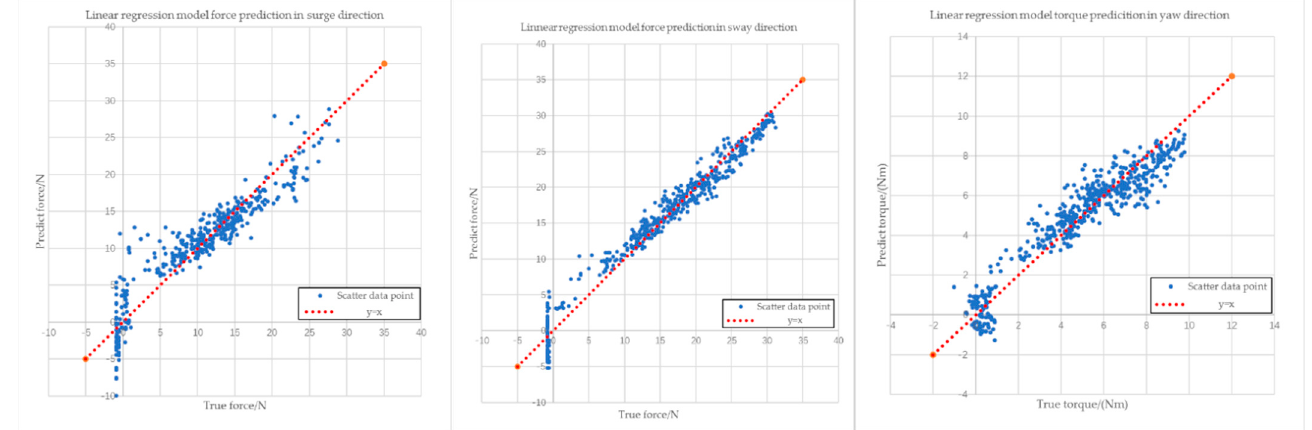
Figure 9. Regression models predicting scatter images in surge, sway and yaw directions. The horizontal axis represents the real disturbance value of the robot measured by the force/torque sensor; the vertical axis represents the disturbance value predicted by the model; the red line is the y = x line; each blue point represents a set of artificial lateral-line data; its abscissa is the corresponding real value of the disturbance; and the ordinate is the predicted value of the disturbance output by the model. Theoretically, the closer the blue point is to the y = x line, the closer the disturbance value predicted by the model is to the real disturbance value, and the better the prediction effect of the model is. On the contrary, the farther the blue point is from the y = x line, the more the disturbance value predicted by the model deviates from the real disturbance value, and the worse the prediction effect of the model is. The distance from the blue point to the red line in the Y -axis direction directly reflects the model error.